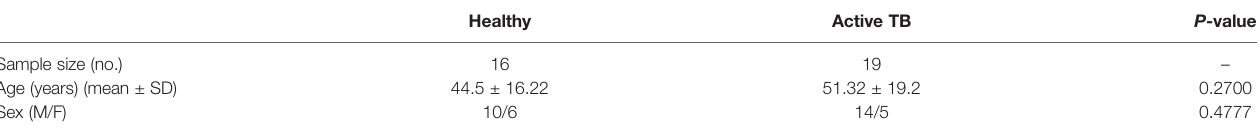
F, Female; M, male. The level of signi fi cance was evaluated by unpaired student t-test or Chi-square test. P-value < 0.05 was considered statistically signi fi cant.